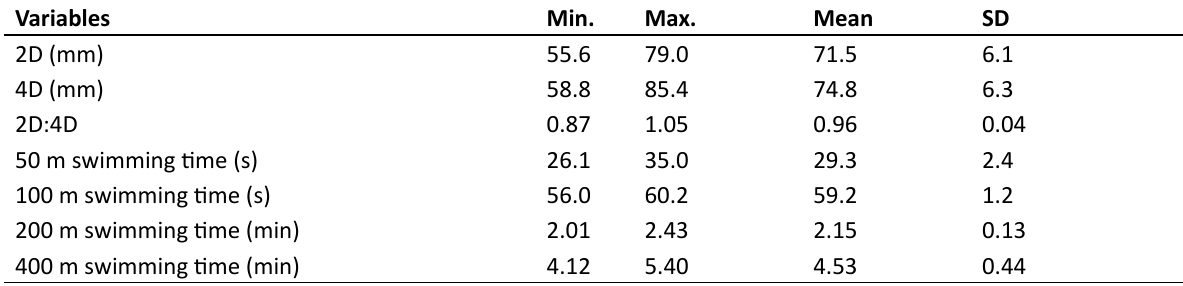
Table 2. The swimming performance data of participants. Variables